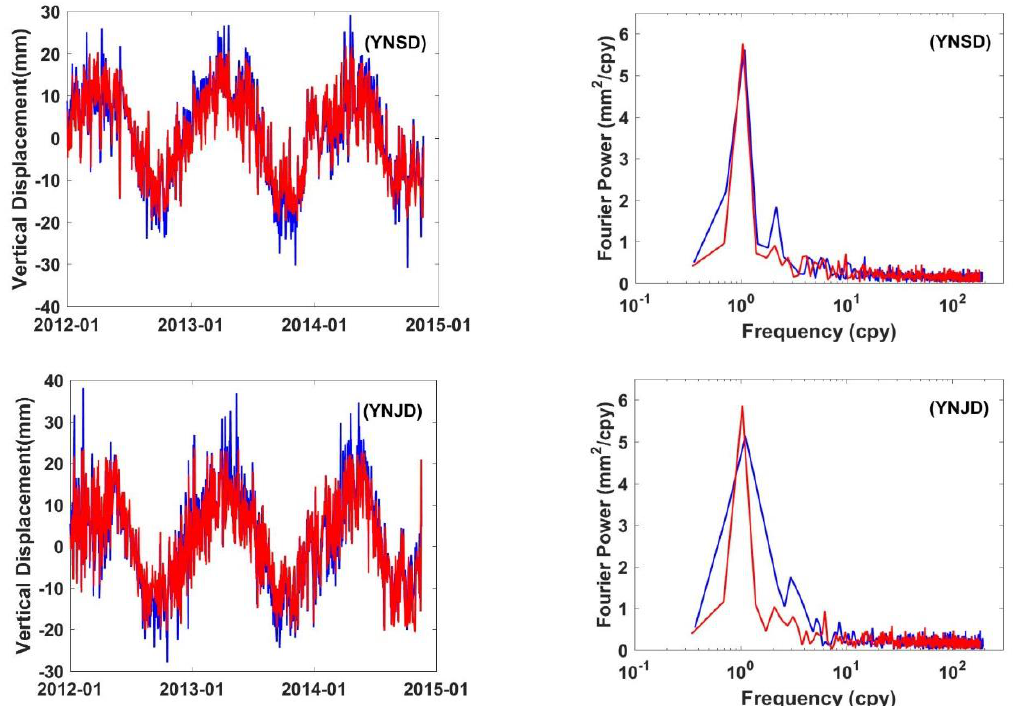
Figure 3. The filtered (in red) and unfiltered (in blue) time series of vertical crustal displacement ( left ) and their corresponding spectra ( right ) for YNSD and YNJD GPS stations.